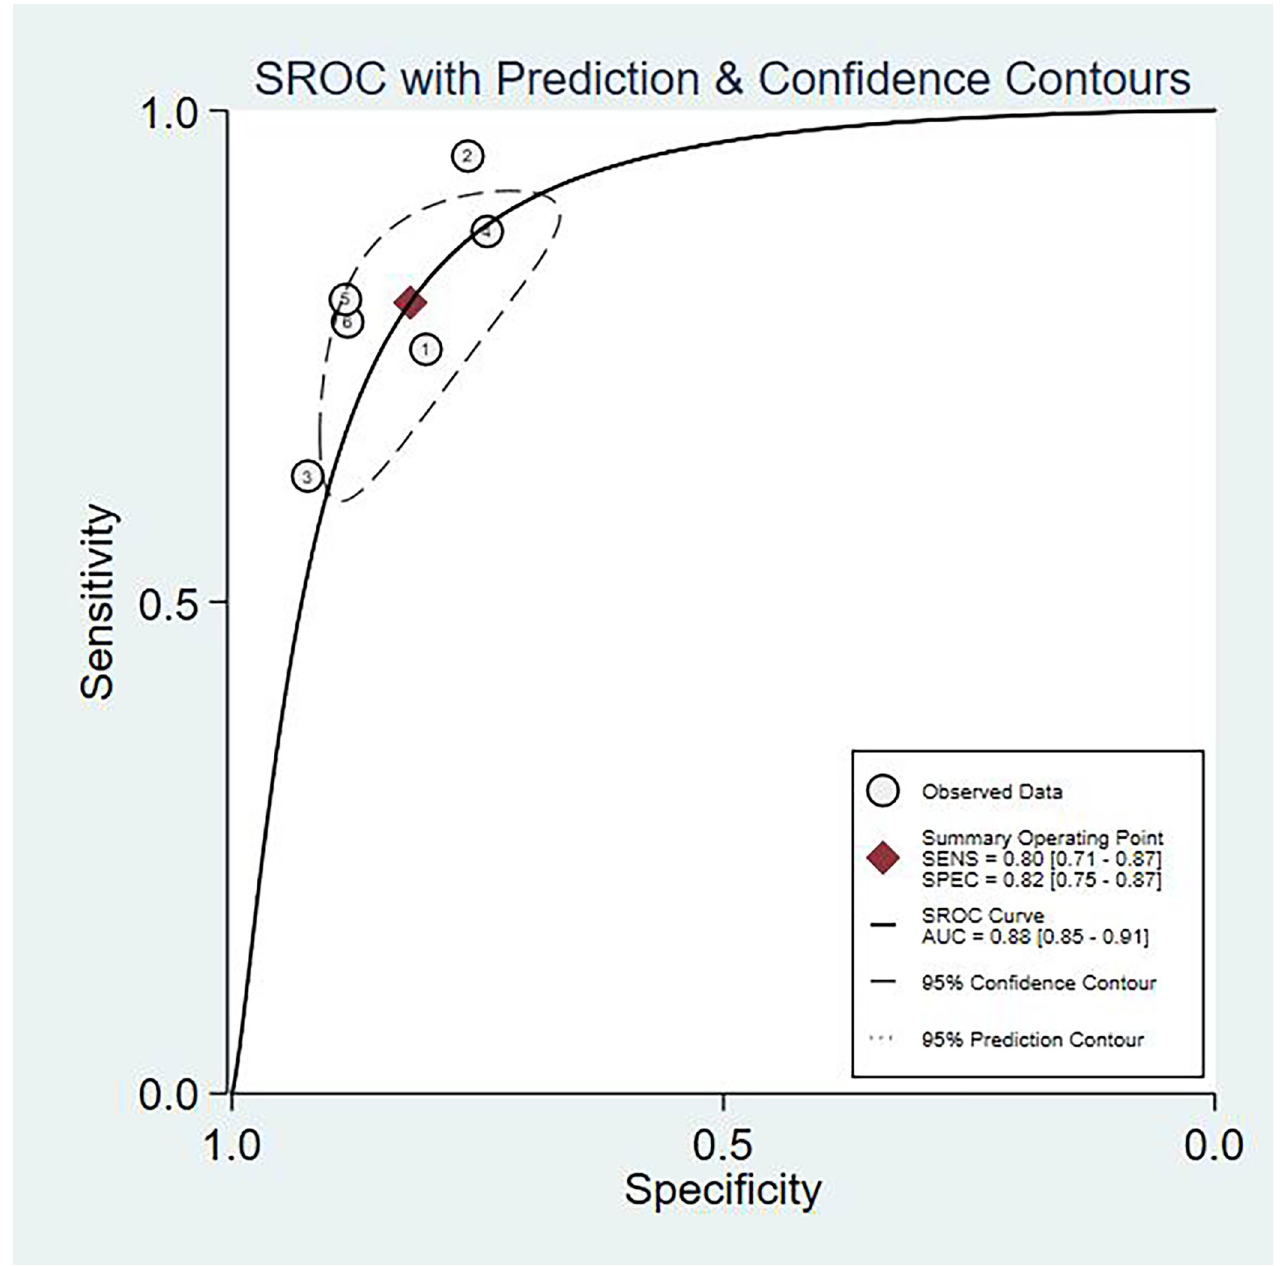
Fig 4. SROC curve for the accuracy of TI-RADS in the diagnosis of thyroid nodules. SROC summary receiver operator characteristic, AUC area under curve.